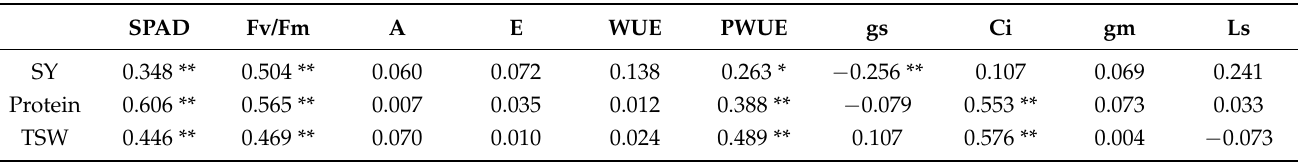
Table 6. Correlation coefficients between physiological characters and seed yield (SY), protein content, and 1000 seed weight (TSW), averaged for the first and second seasons.